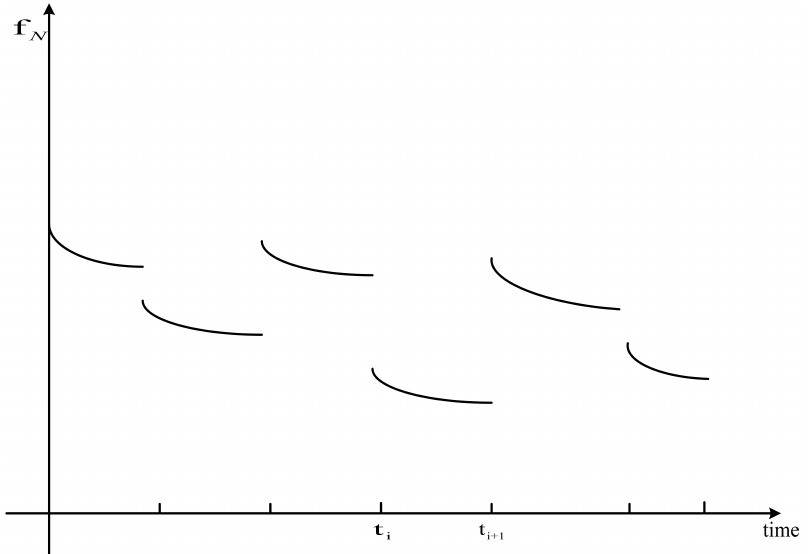
Figure 5. The force f